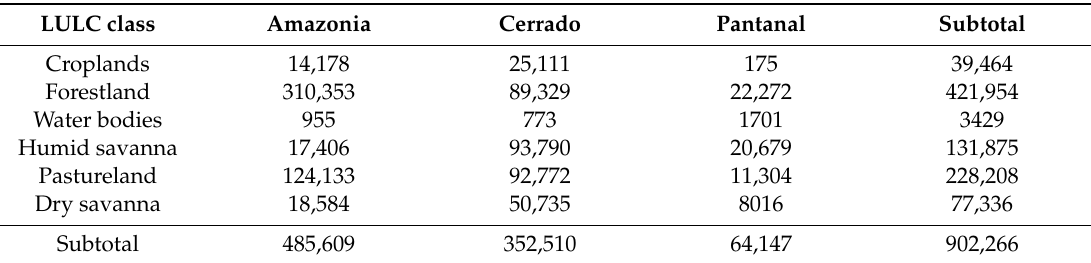
Figure 8. Land use and land cover map of Mato Grosso state derived from the maximum and standard deviation fraction images of 2015. Identification of indigenous lands: 1 = Parque do Xingu; 2 = Parque do Aripuan ã ; and 3 = Paresi. Cuiab á is the capital of Mato Grosso state. Table 2. Area (km 2 ) occupied by the representative LULC classes of Mato Grosso state, estimated according to the PROBA-V 100-m classification by the random forest